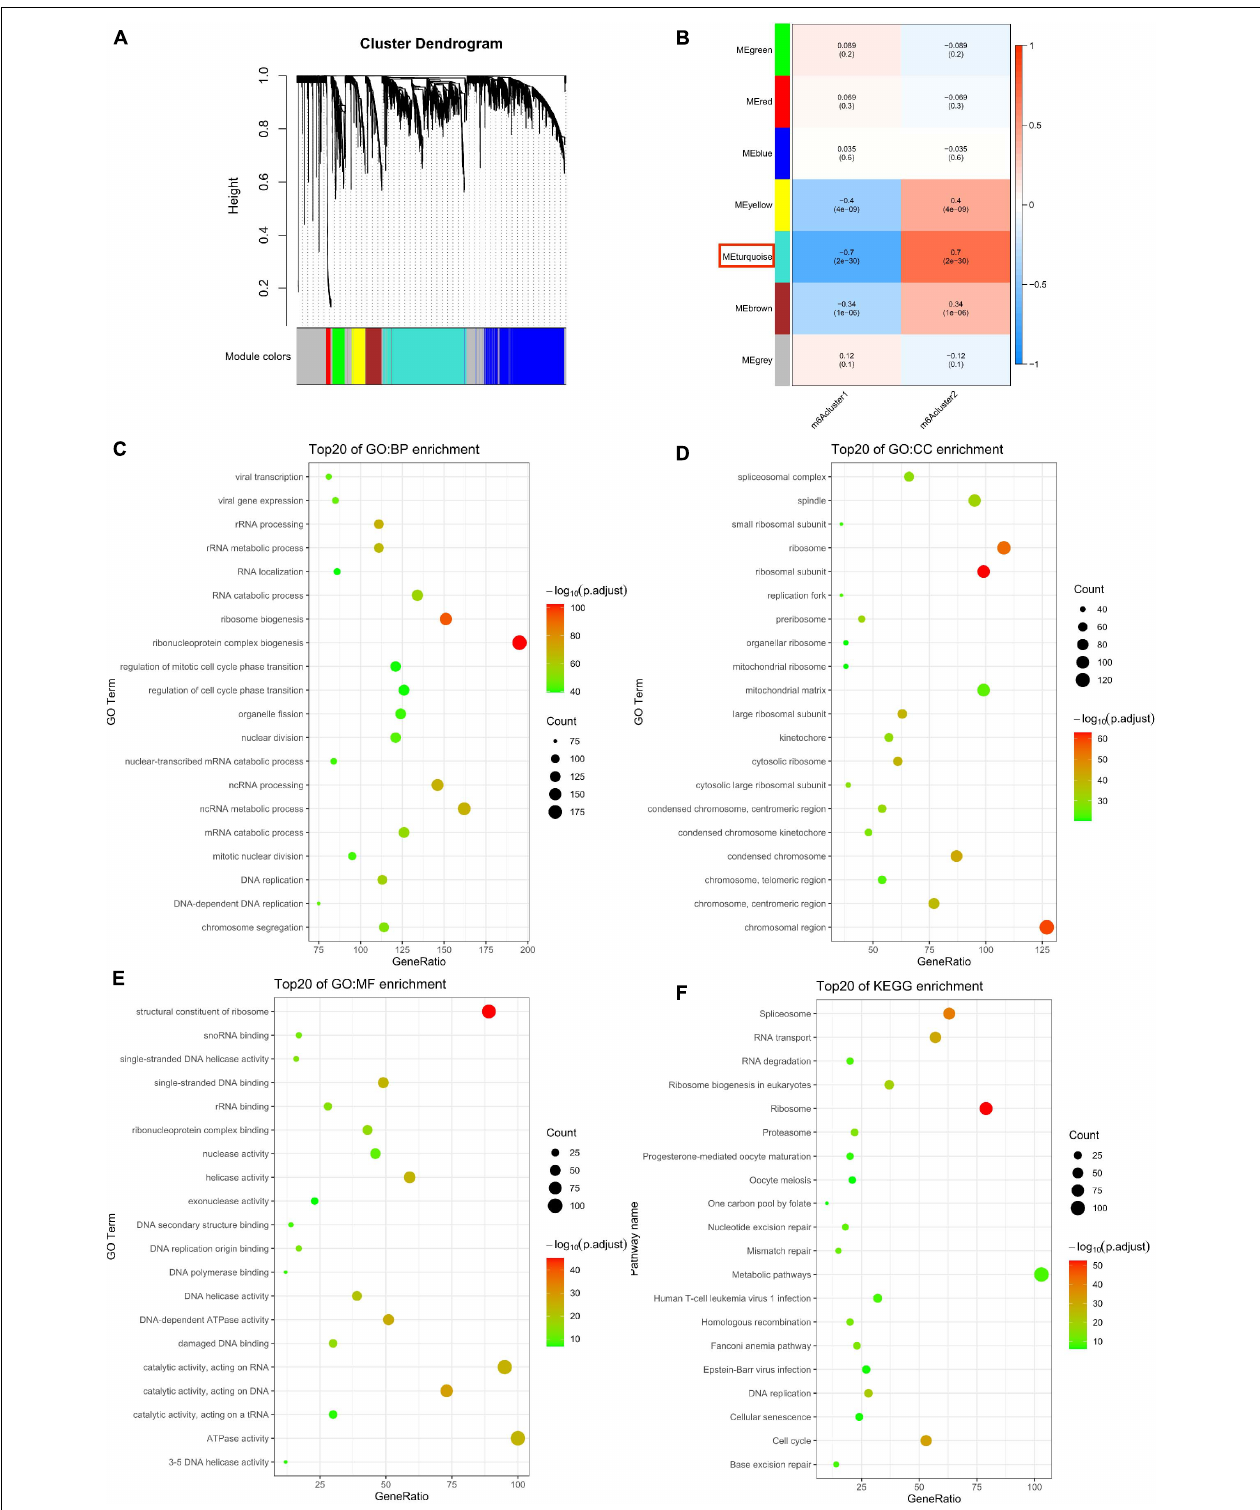
FIGURE 3 | Biological characteristics of key m 6 A module. (A) Gene dendrogram obtained by average linkage hierarchical clustering. (B) The correlation between the module eigengenes and m 6 A modification patterns. (C–F) Functional annotation of the genes in the key m 6 A module by using Gene Ontology (GO) terms of biological processes (BP) panel (C) , cellular component (CC) panel (D) , molecular function (MF) panel (E) , and Kyoto Encyclopedia of Genes and Genomes (KEGG) pathway (F) .